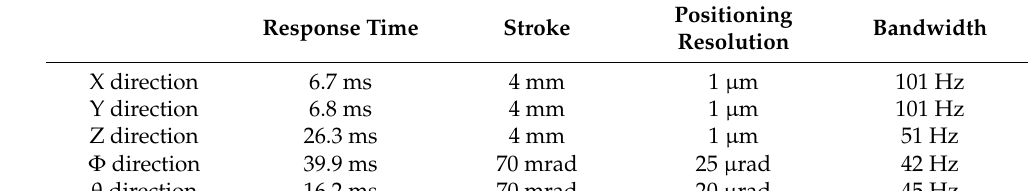
Table 3. Performance evaluation results table.